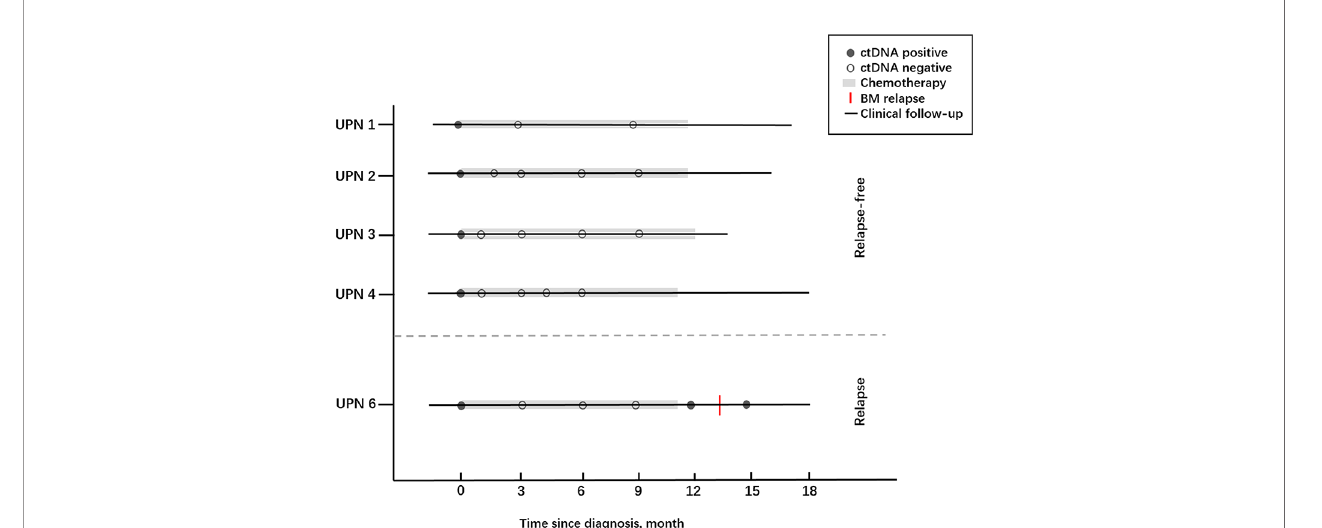
FIGURE 9 | The clinical courses together with ctDNA statuses of fi ve AML children who received chemotherapy.